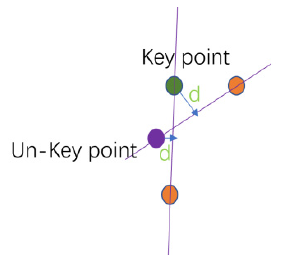
Figure 13. The process of the key point generation. The green point defines the key point and the purple one is the unkey point. purple one is the unkey